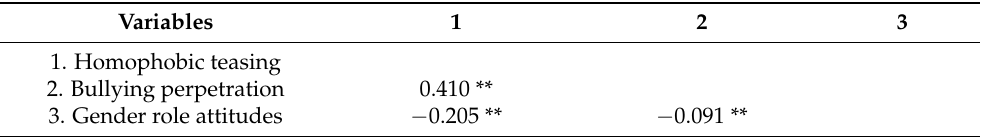
Table 2. Pearson correlations between variables.